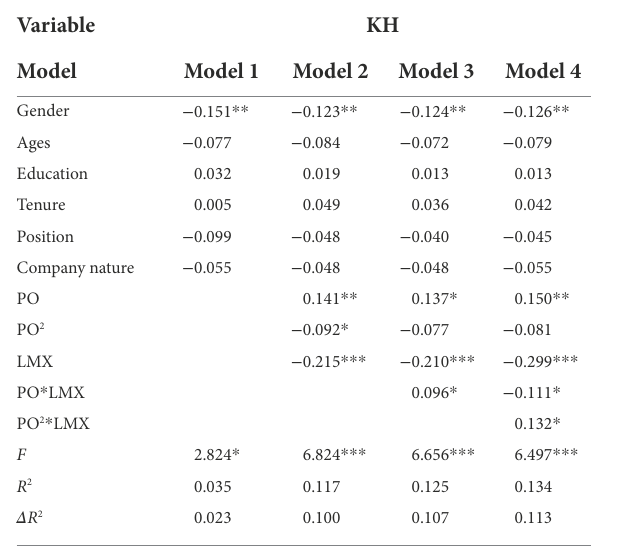
TABLE 7 Moderating effects of leader-member exchange ( N = 475).